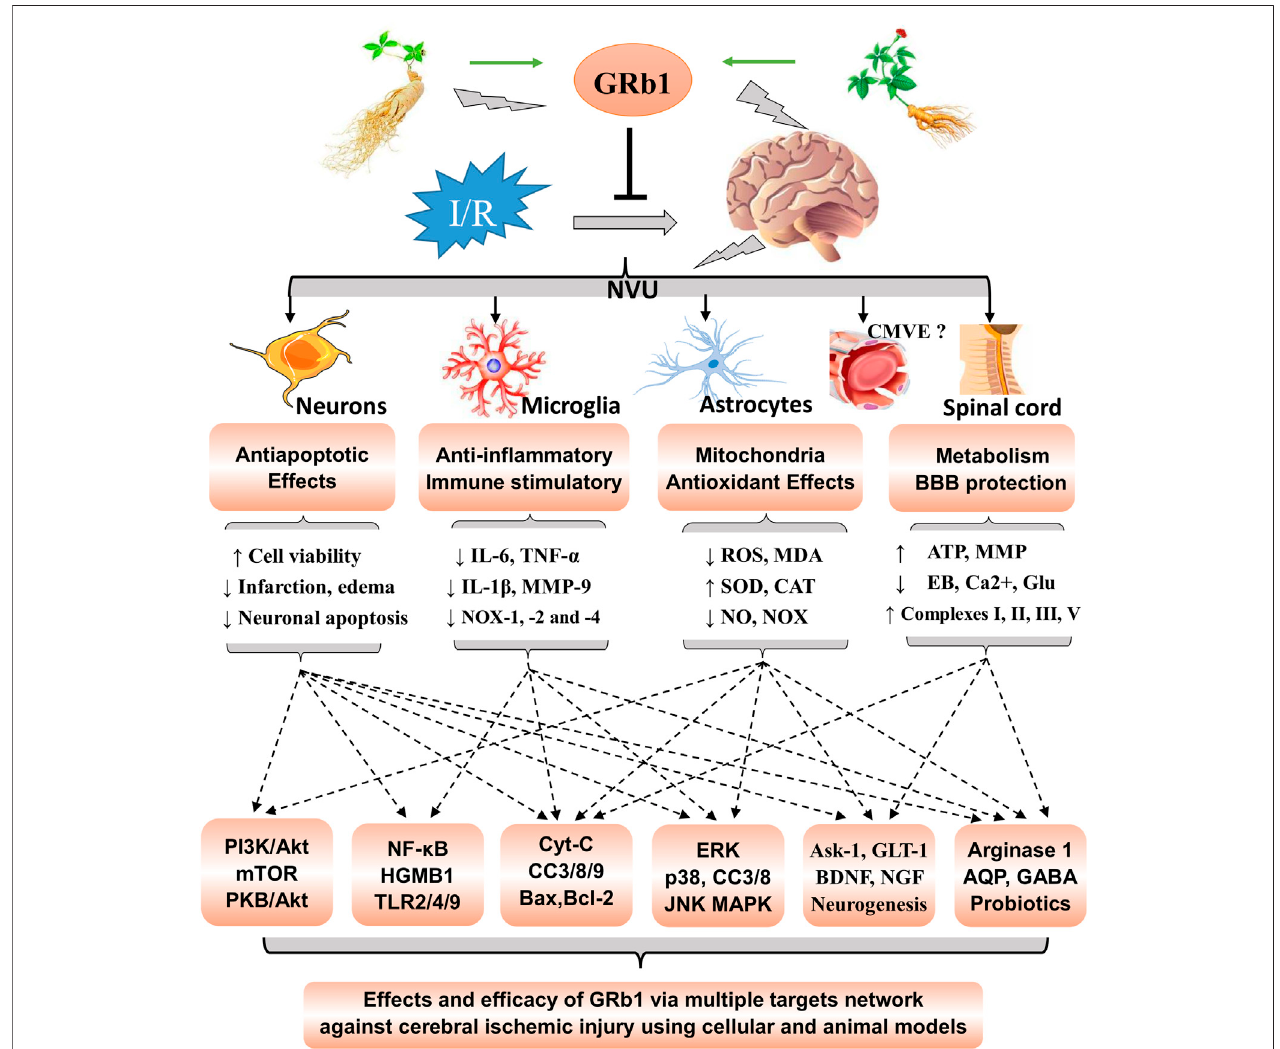
FIGURE 2 | Summarized effects and molecular network analysis of GRb1 in cerebral ischemic injury. Rb1 exerts signi fi cant neuroprotective effects on the neurovascular unit (NVU) and other neural cells via the network actions of its antiapoptotic, antioxidant, and anti-in fl ammatory activities; mitochondrial homeostasis; neurogenesis promotion; and regulation of the probiotic balance. The molecular mechanisms involve multiple effects, multiple targets, and multiple pathways. NVU, neurovascular unit; CMVE, cerebral microvascular endothelium. GRb1, ginsenoside Rb1; I/R, indicates ischemia and reperfusion. CC, cleaved caspase.